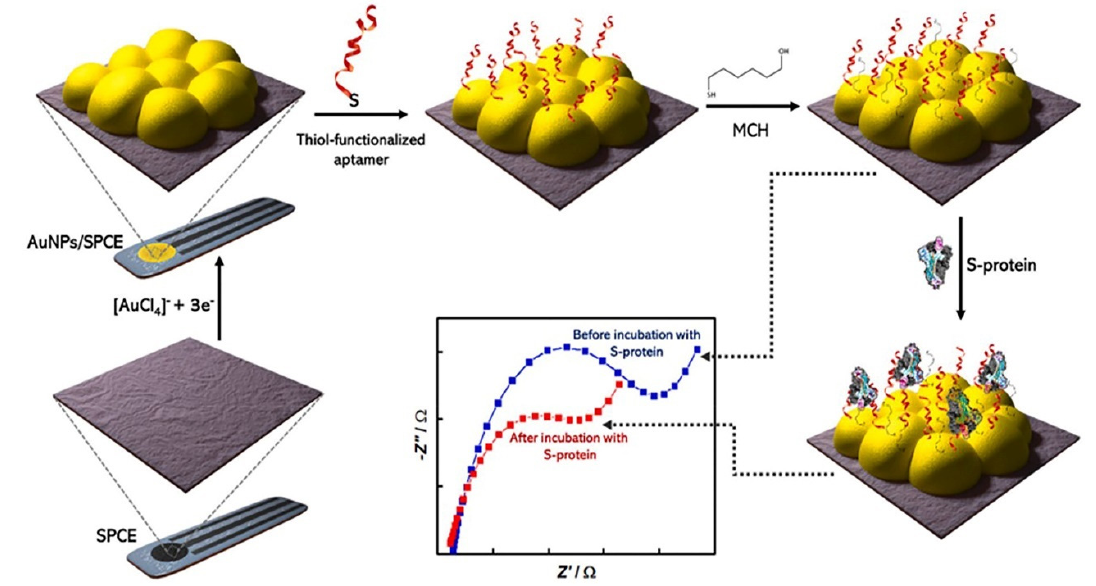
Figure 9. Nucleic acid-based electrochemical biosensors for SARS-CoV-2 detection. Fabrication steps of an aptasensor for SARS-CoV-2 S-protein detection. Reproduced with permission from [65]. Copyright 2022, Elsevier.